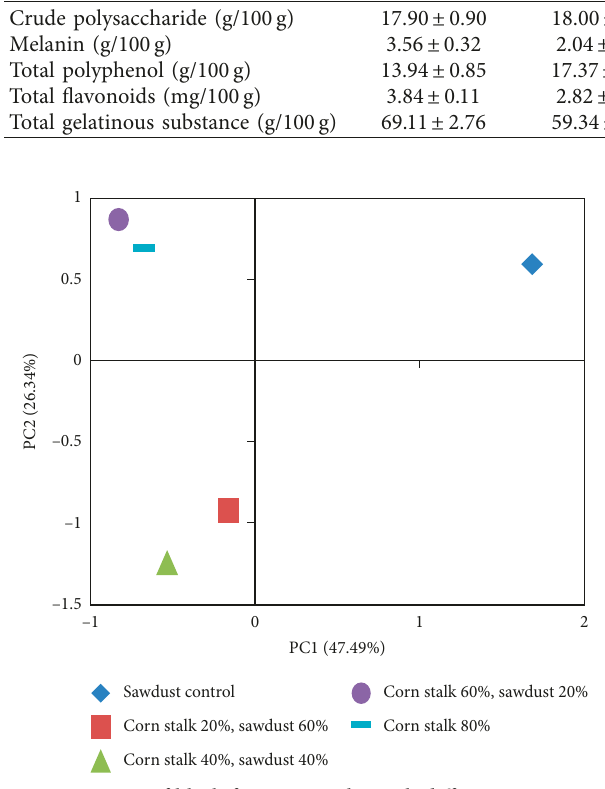
Figure 1: PCA of black fungus samples with different treatments under investigation of score plots.